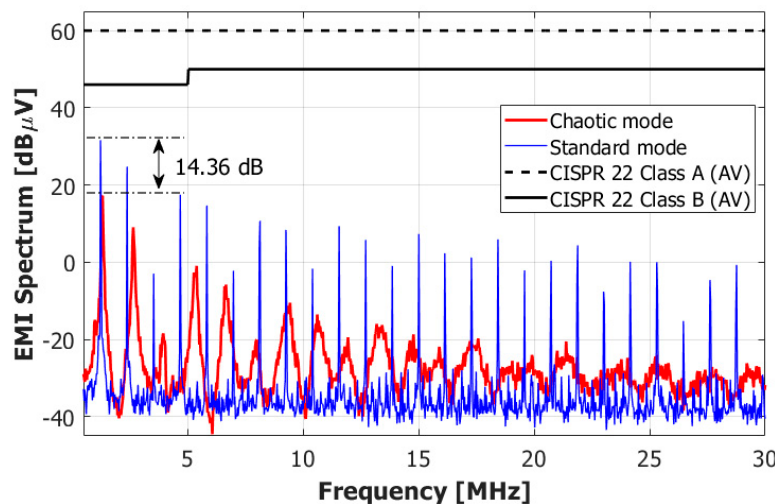
Figure 19. Conducted emission measurement of the buck converter.